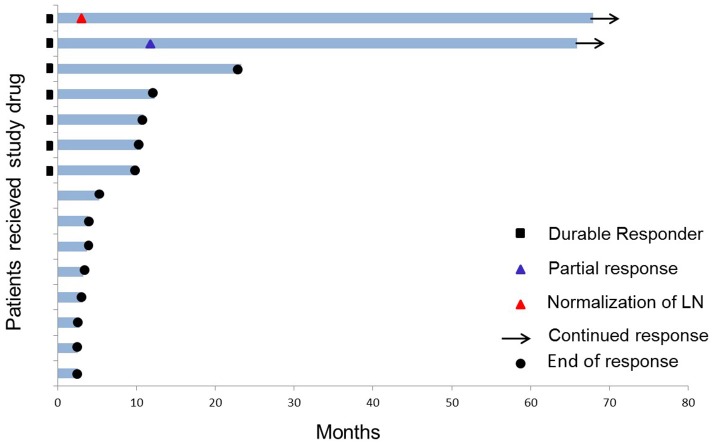
Swimmer plot of the 15 stage III–IV HLA-A2+ NSCLC patients who received study drug (IDO peptide vaccine). Two of 15 patients are long-term responders (as of 6 years after the 1st vaccine). Durable response is defined as >8.5 months clinical treatment benefit.